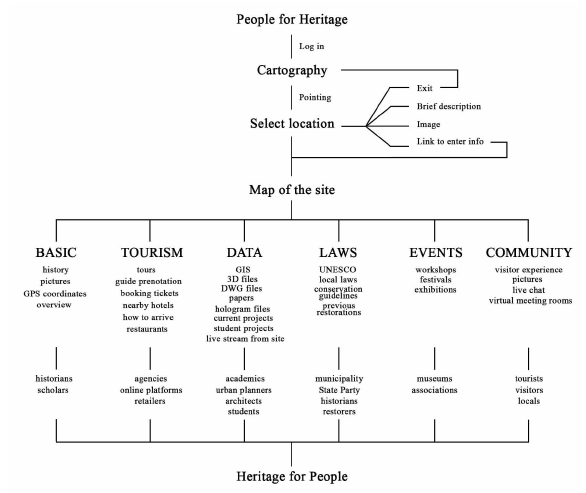
Figure 1 . Platform